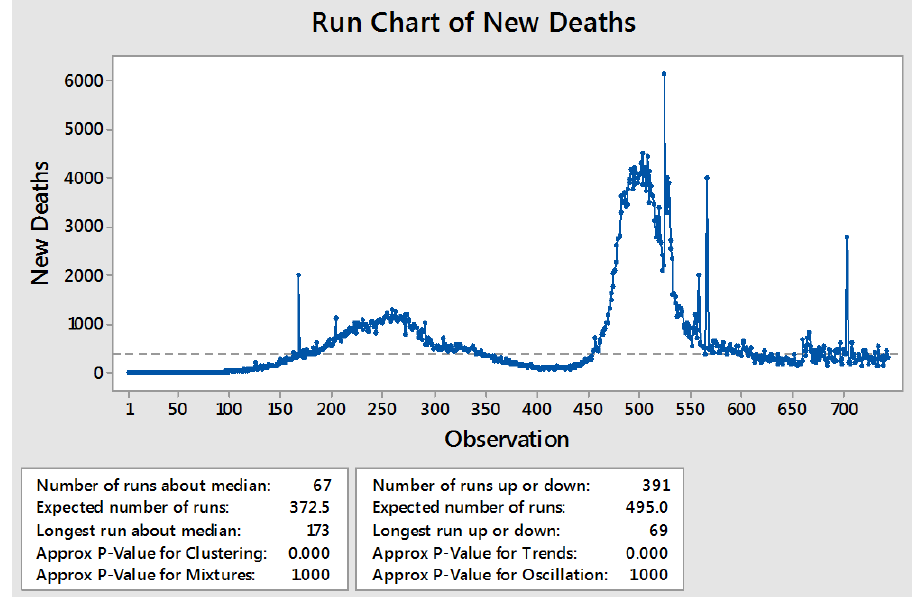
Figure 4. Time series plot of SARS-CoV-2 morbidity and mortality over two years displaying outbreak waves The approximate p-values for mixtures and oscillation are all greater than the significance level (α) of 0.05, in contrast to the clustering and trend patterns which are below 0.05. Hence, the P-value is 1.000 in the first two and